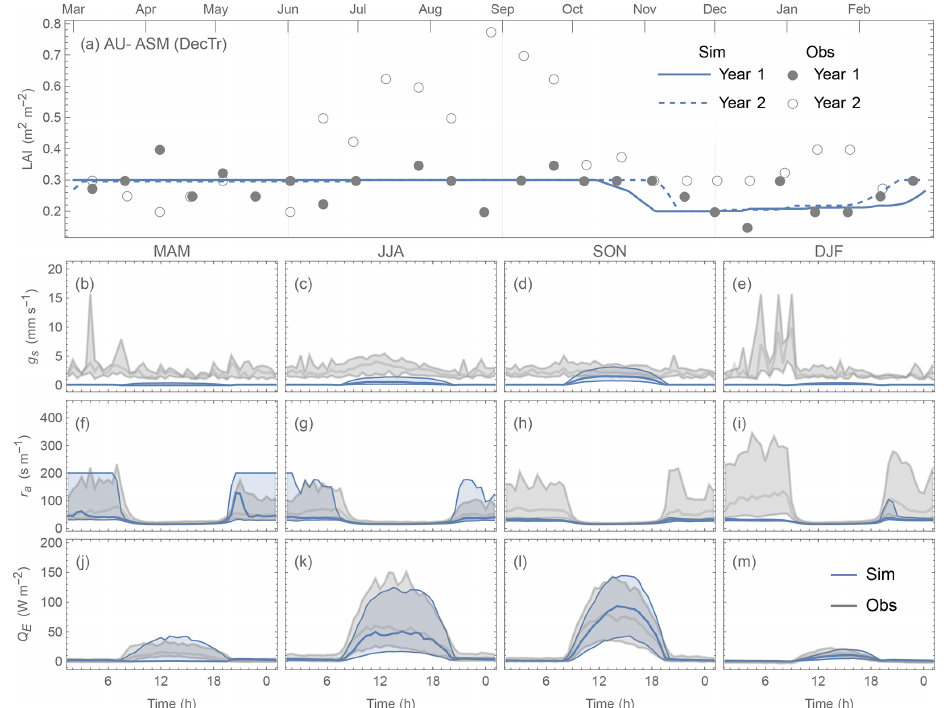
Figure 21. As Fig. 19, but for AU-ASM (DecTr, PS = 0.96).